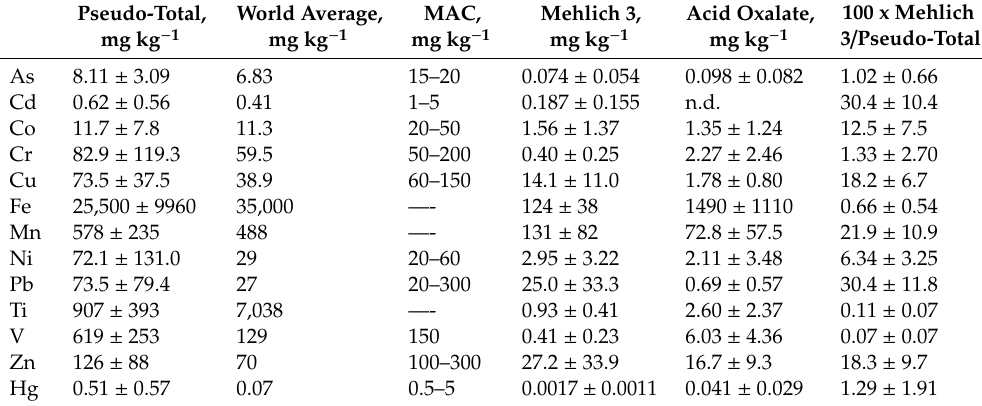
Table 1. Concentrations of potentially toxic elements (PTEs) for the 35 soils studied: average ± standard deviation, along with world soil average and maximum allowable concentrations (MAC) for agricultural soils according to Kabata-Pendias [27] (see also Table